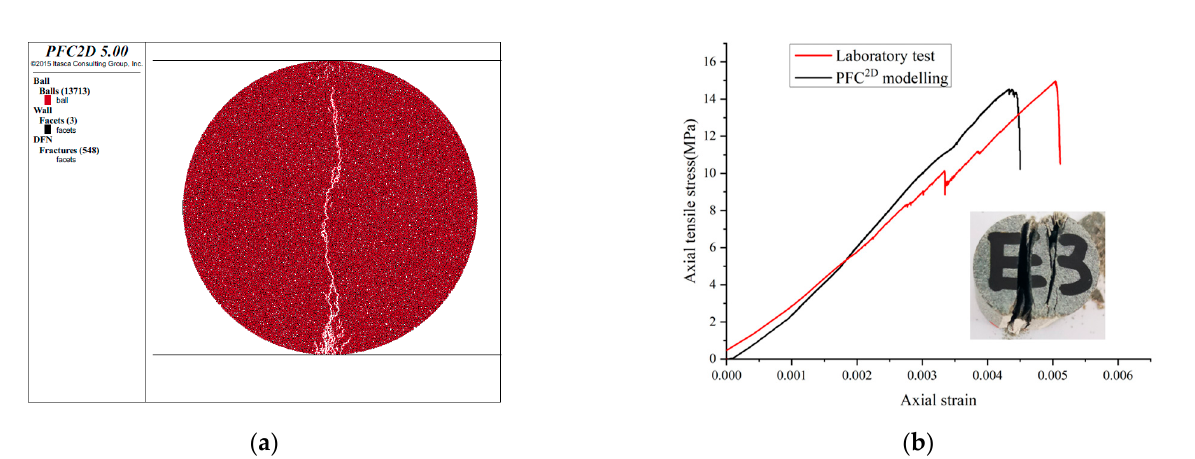
Figure 3. Calibration of the contact model to the laboratory specimen under Brazil test: ( a ) numerical simulation of tensile test; ( b ) comparison of experimental results with numerical simulation results. Figure 2. Calibration of the contact model to the laboratory specimen under UCS test: ( a ) numerical simulation of UCS test; ( b ) comparison of experimental results with numerical simulation results. Table 2. Calibrated microscopic properties of the sandstone model.